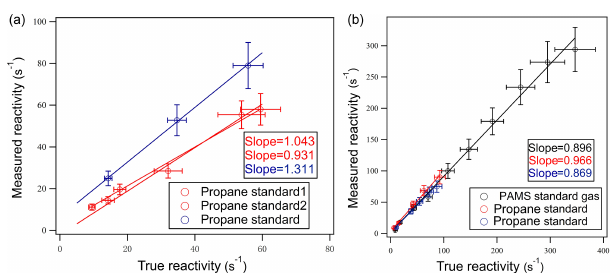
Figure 2. OH reactivity calibration in Beijing (a) and Heshan (b) . Left: calibration in Beijing using two single standards: propane and propene. Right: calibration in Heshan using three standards: propane, propene and mixed PAMS 56 non-methane hydrocarbons (NMHCs). Error bars stand for estimated uncertainty of the mea- sured and true reactivity.